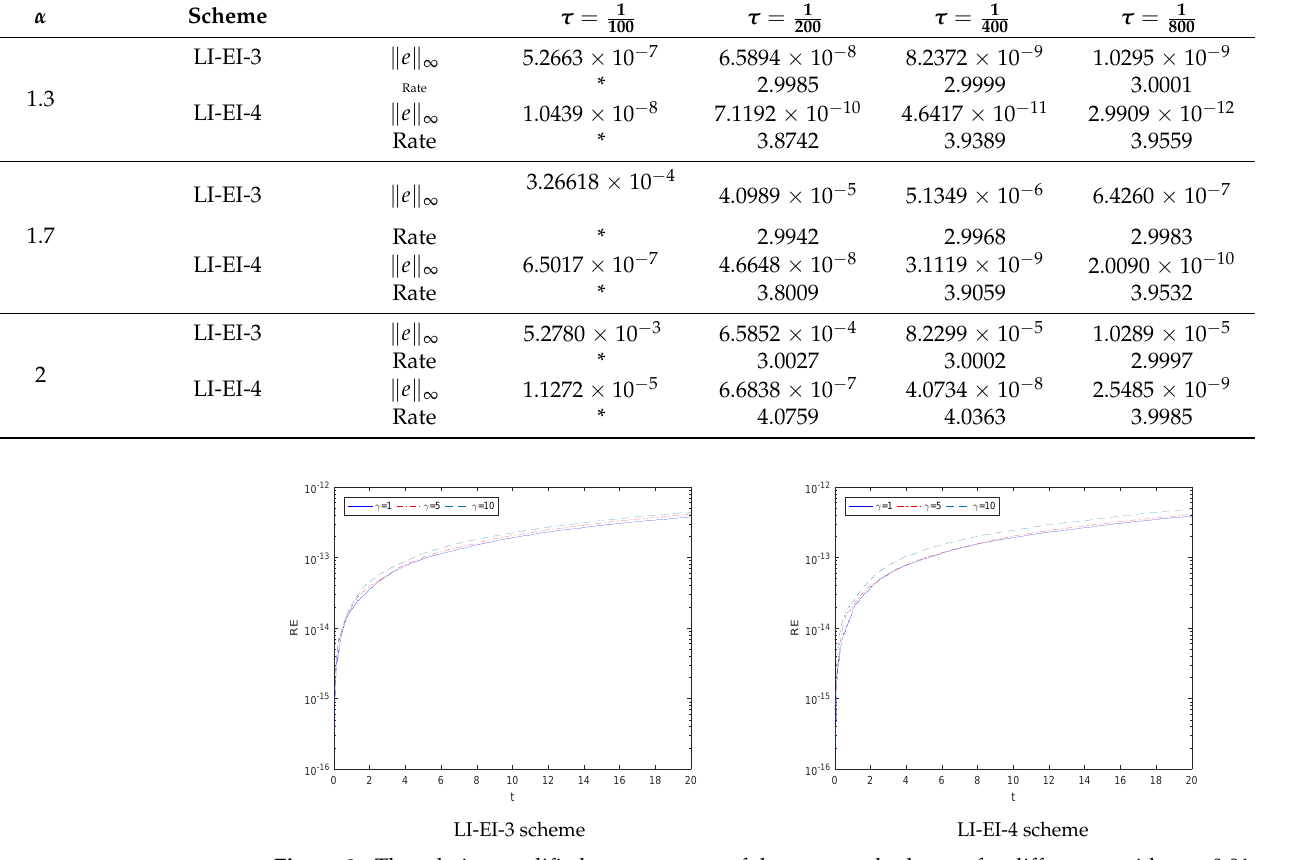
Figure 3. The relative modified energy errors of the proposed schemes for different α with τ =